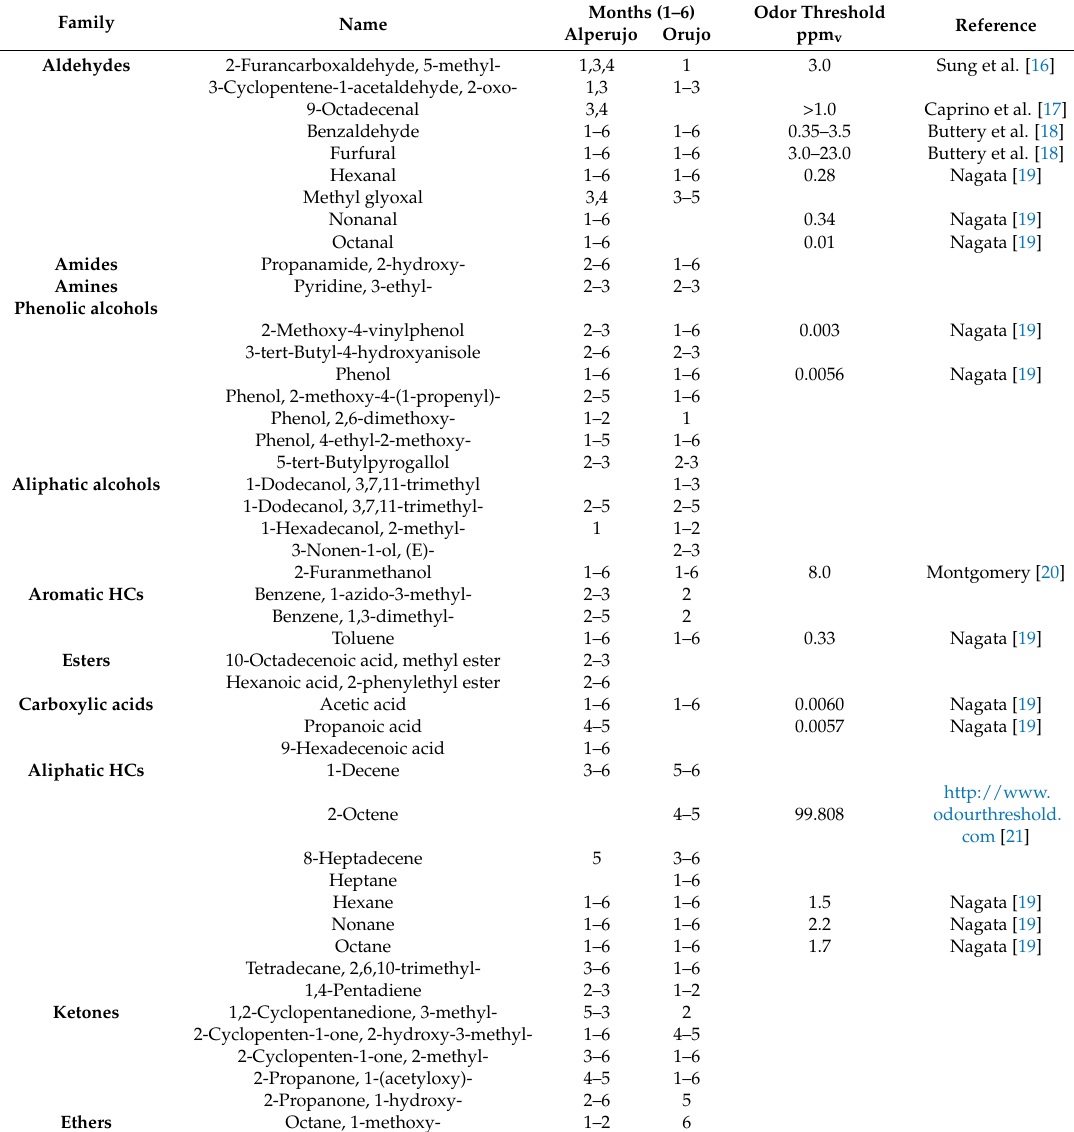
Table 3. Selected VOCs detected during the drying process for alperujo and orujo samples.